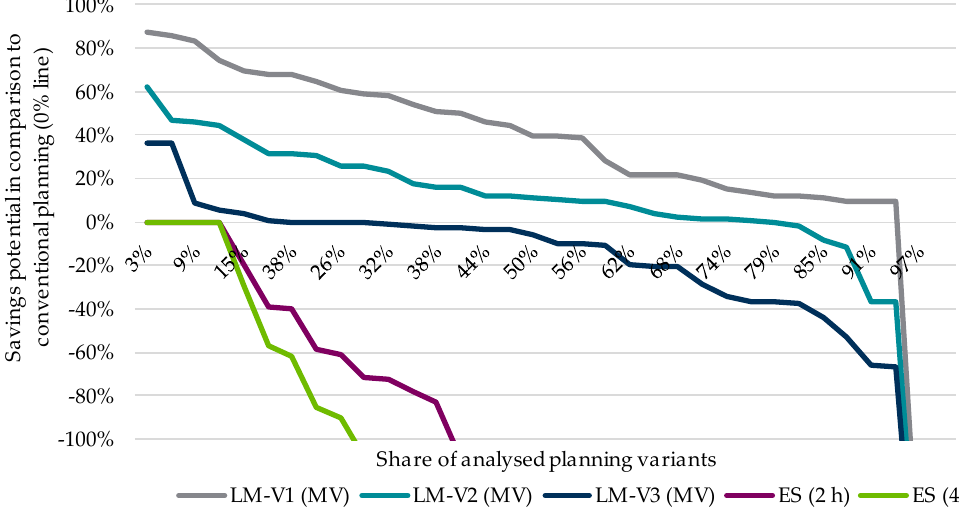
Figure 11. The savings potential for innovative planning strategies in comparison to conventional planning per planning variant.